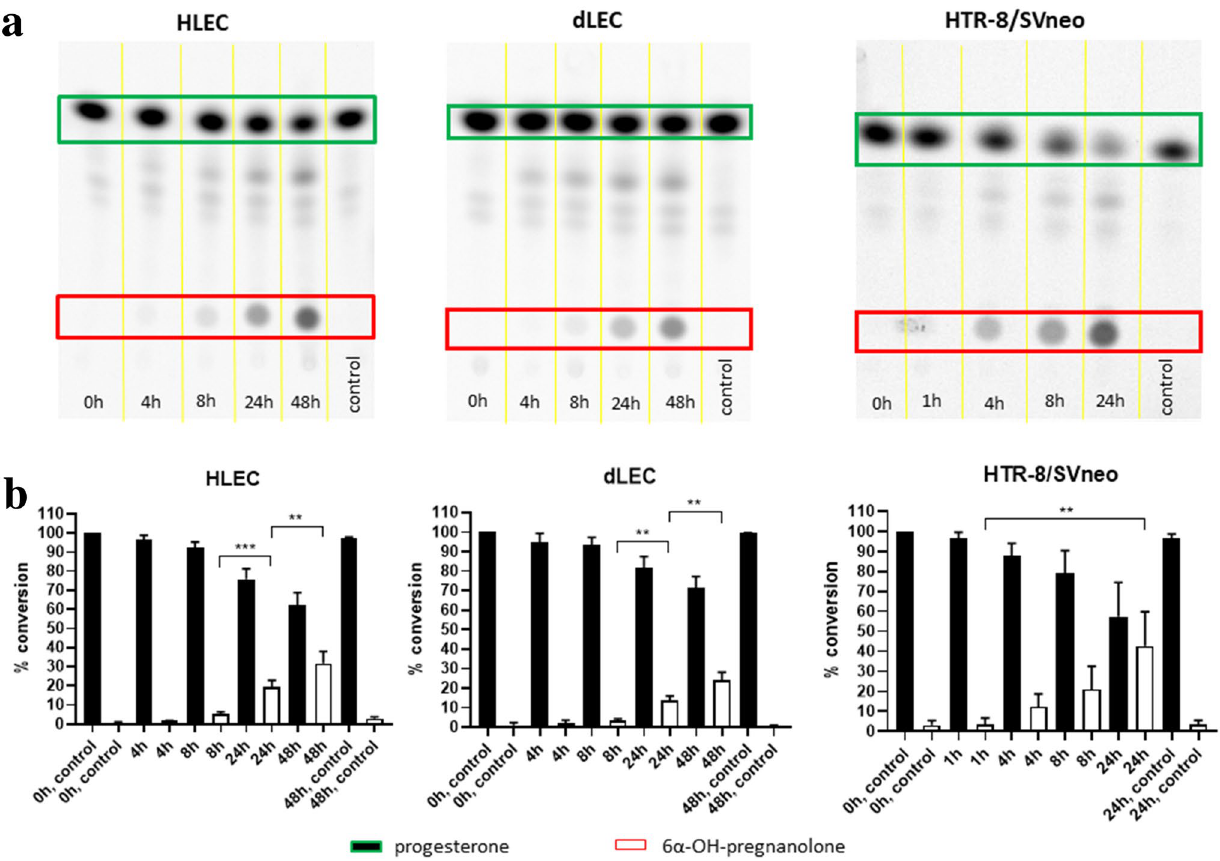
Figure 1. Characterization of progesterone metabolism in HLEC, dLEC and HTR8/SV neo by TLC . Metabolism of progesterone in HLEC, dLEC and HTR-8/SV neo. ( a ) Characteristic phosphorimager pictures of time-dependent conversion of progesterone to a main metabolite, 6α-OH-pregnanolone. Cell-free controls were run for time point 0 h (HLEC, dLEC and HTR-8/SV neo), for time point 24 h (HTR-8/SVneo) and for time point 48 h (HLEC and dLEC). ( b ) Densitometric quantification of all performed experiments. Progesterone was time-dependently and significantly converted to 6α-OH-pregnanolone in all three cell lines. Data were normalized to condition 0 h = 100% progesterone. One-way ANOVA, Dunnett’s multiple comparisons test, n = 5. Production of 6α-OH-pregnanolone: HLEC: 8 h-24 h *** p < 0.0001, 24 h-48 h ** p = 0.0002. dLEC: 8 h-24 h ** p = 0.0026, 24 h-48 h ** p = 0.0020. HTR-8/SV neo: 1 h-24 h ** p = 0.0002. Green rectangle/black column: substrate (progesterone). Red rectangle/white column: product (6α-OH-pregnanolone). * p < 0.05, ** p < 0.01, *** p < 0.0001, ns = not Derived cascade of progesterone metabolism in HLEC, dLEC and HTR‑8/SV neo. Based on our findings by Real-time PCR, LC–MS and Thin layer chromatography, progesterone is metabolized via 5α-DHP and allopregnanolone to 6α-OH-pregnanolone in HLECs, dLECs and HTR-8/SVneo (Fig. 4). Furthermore, HLEC and dLEC efficiently back-convert 20α-hydroxyprogesterone to progesterone due to high HSD17B2 expression. Inhibition of 6α‑OH‑pregnanolone formation in HLEC, dLEC and HTR‑8/SV neo using the SRD5A1‑3 inhibitor dutasteride. HLECs, dLECs and HTR-8/SV neo cells were cultured and incubated for 24 h with the 5α-reductase inhibitor dutasteride at 2 different concentrations, 10 −5 M and 10 −6 M for HLEC and HTR-8/SV neo and 10 −6 M and 10 −8 M for dLEC. Supernatants were analyzed by TLC to measure the conversion of 14 C-progesterone to 6α-OH-pregnanolone (Fig. 5). Dutasteride significantly inhibited 6α-OH- pregnanolone formation at both concentrations in all three cell lines. In untreated HLECs (DMSO) 39.2% ± 6.3% 6α-OH-pregnanolone was produced from progesterone (Fig. 5a). This production was reduced to 6.3% ± 5.8%, respectively 6.2% ± 4.7% with dutasteride 10−5 M and 10−6 M. A similar inhibitory effect by dutasteride was observed in dLECs (Fig. 5b) and HTR-8/SV neo cells (Fig. 5c). In dLECs, production of 6α-OH-pregnanolone went from 14.5% ± 0.9% to 4.1% ± 0.6% with dutasteride 10−6 M and to 5.7% ± 0.2% with dutasteride 10−8 M. Similarly, HTR-8/SV neo cells produced 32.1% ± 9.1% 6α-OH-pregnanolone (DMSO), and this was reduced to 3.0% ± 2.7% with dutasteride 10−5 M and to 3.7% ± 2.9% with dutasteride 10−6 M. The involvement of the SRD5A1-3 for the production of 6α-OH-pregnanolone was confirmed by enzymatic activity and RT-PCR. One- way ANOVA, Dunnett’s multiple comparisons test. Mean ± SD, n = 3.